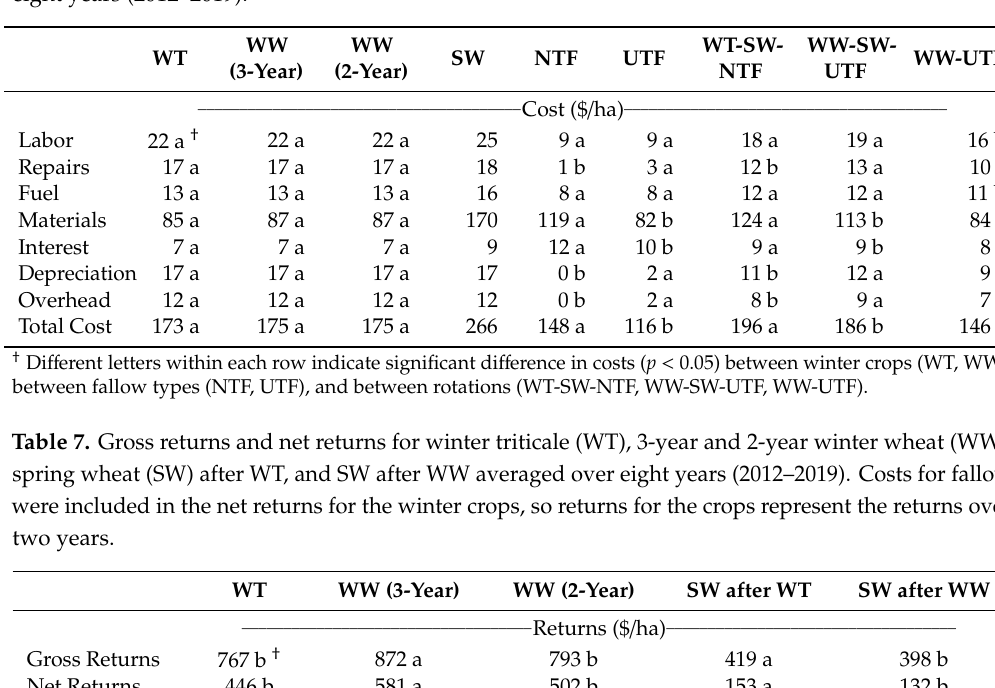
Table 6. Average annual costs for winter triticale (WT), 3-year and 2-year winter wheat (WW), spring wheat (SW), no-till fallow (NTF), undercutter tillage fallow (UTF), and rotation averages over eight years (2012–2019).